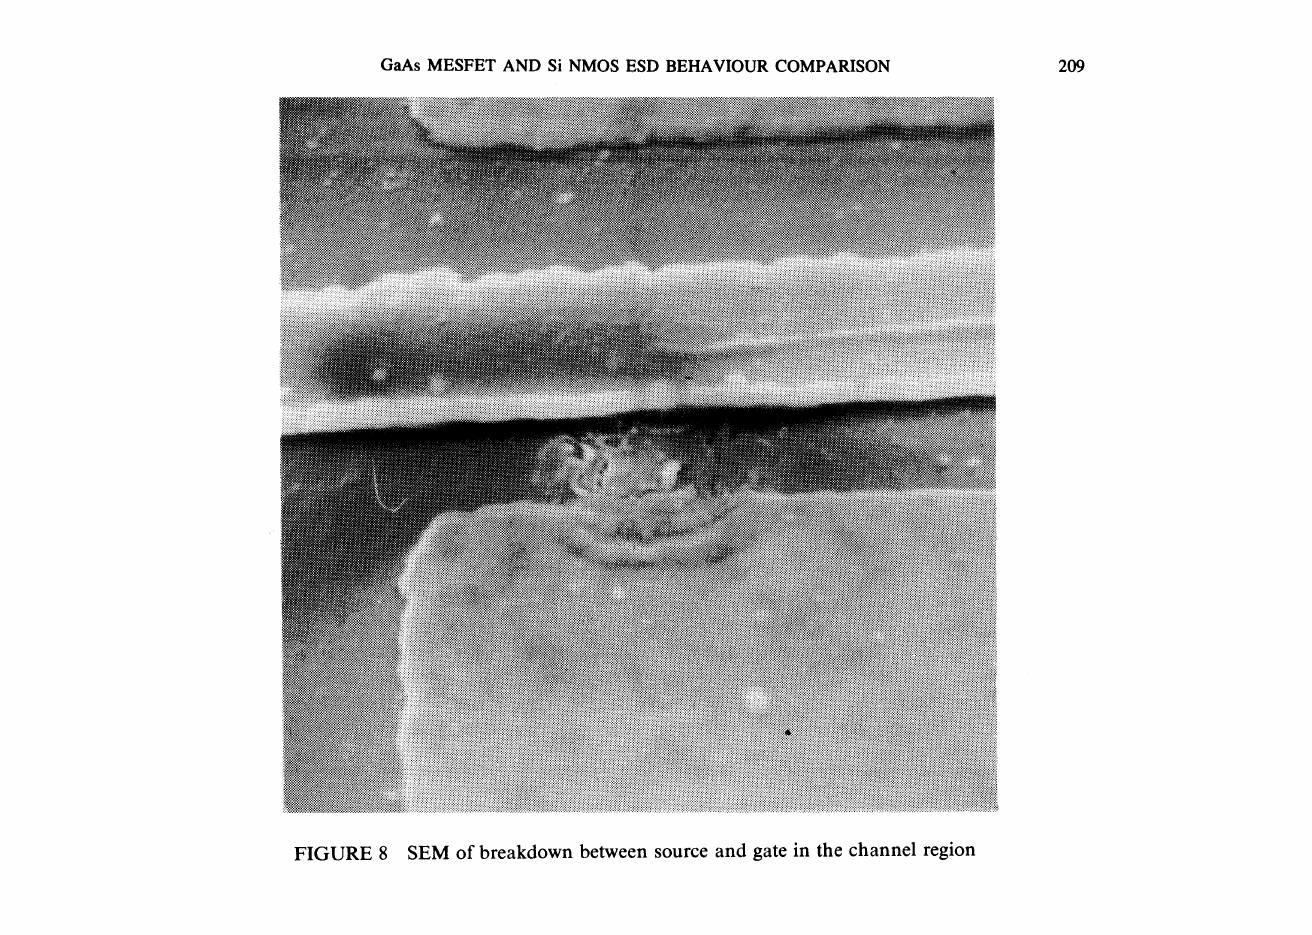
FIGURE 8 SEM of breakdown between source and gate in the channel